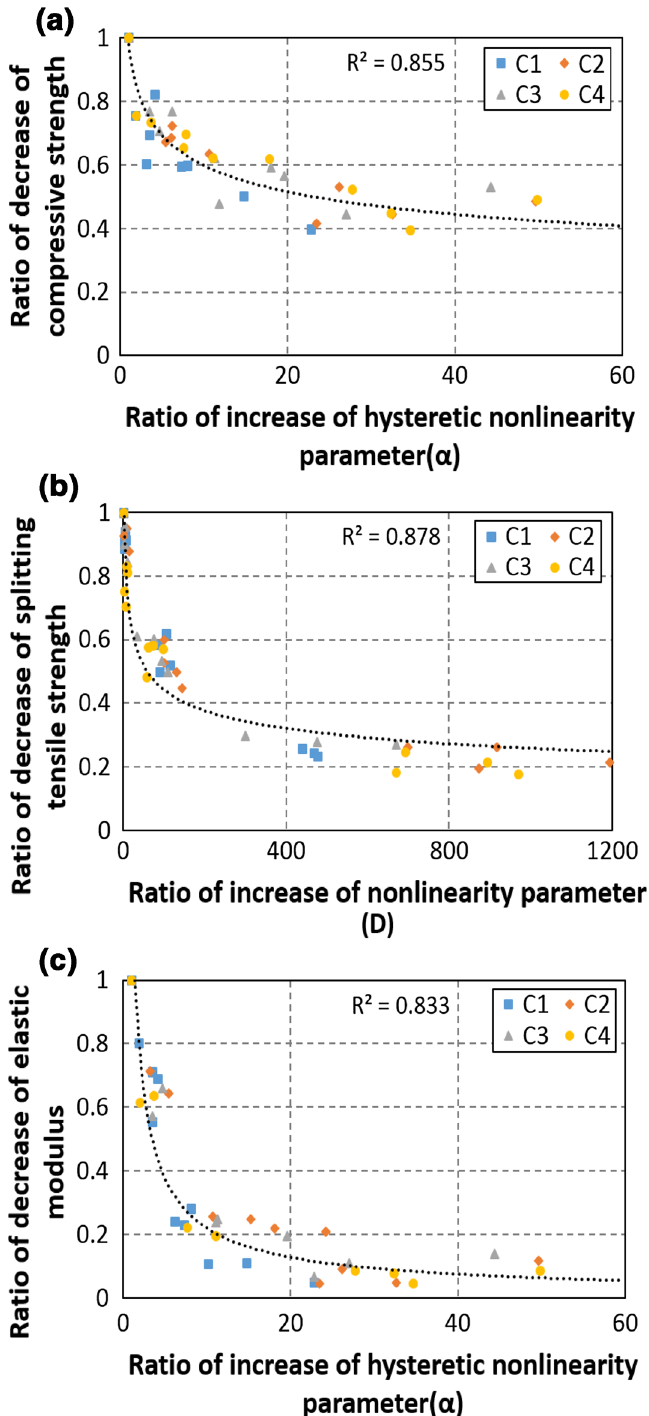
Fig. 8 Correlation between ratio of decrease of the residual material properties and ratio of increase of the nonlinearity